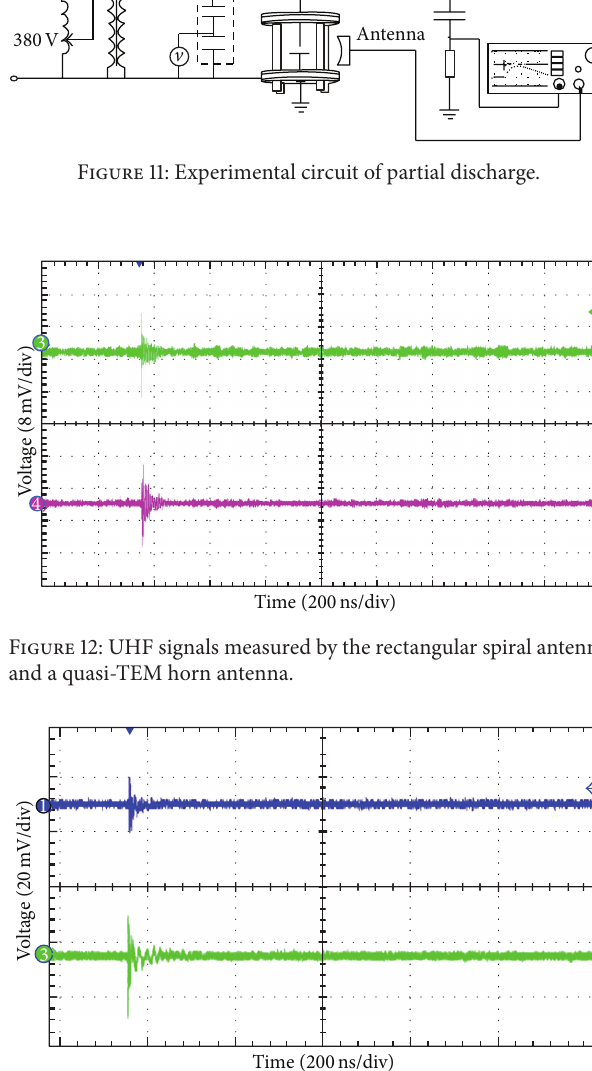
Figure 13: UHF signals measured by the rectangular spiral antenna and a microstrip patch